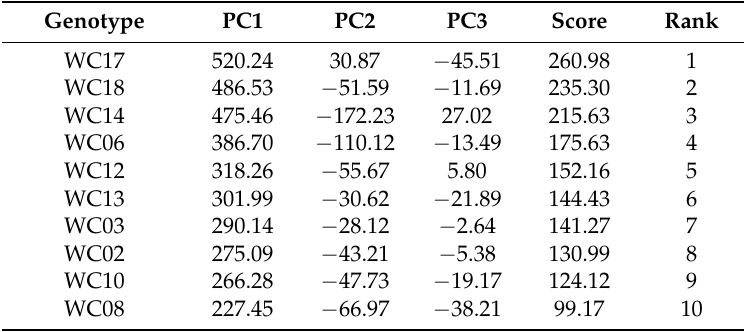
Table 6. PCA Ranking Values of the Agromorphological, Biochemical and Physiological Traits of Sesame Genotypes.